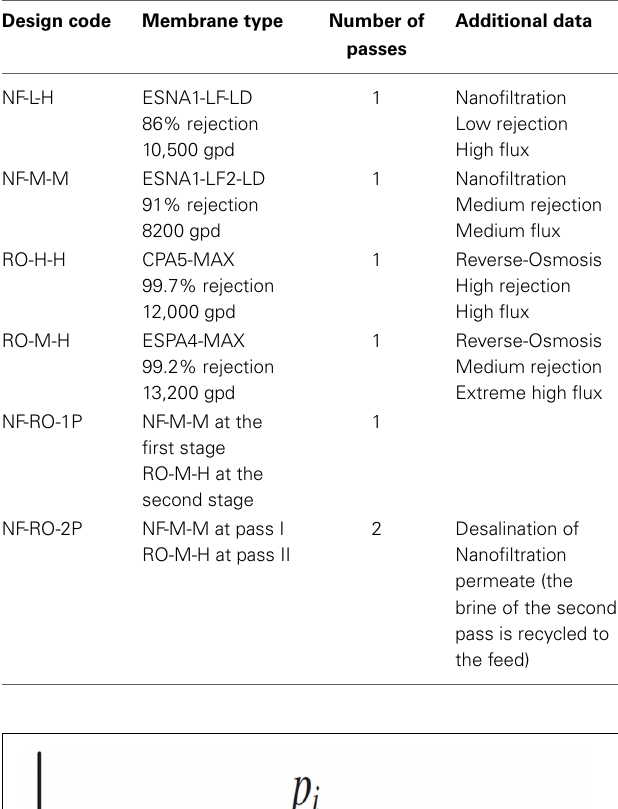
Table 2 | Production technologies for irrigation.